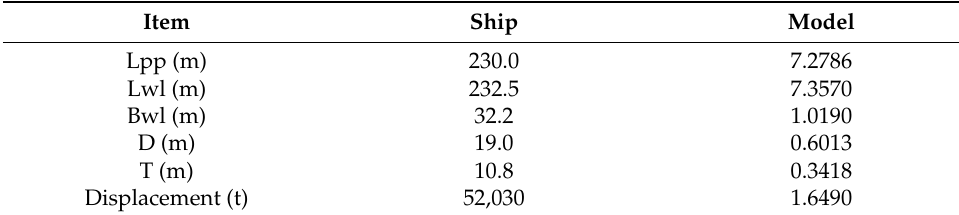
Figure 5. KCS container ship geometry model. Table 4 . Main dimensions of KCS ship.